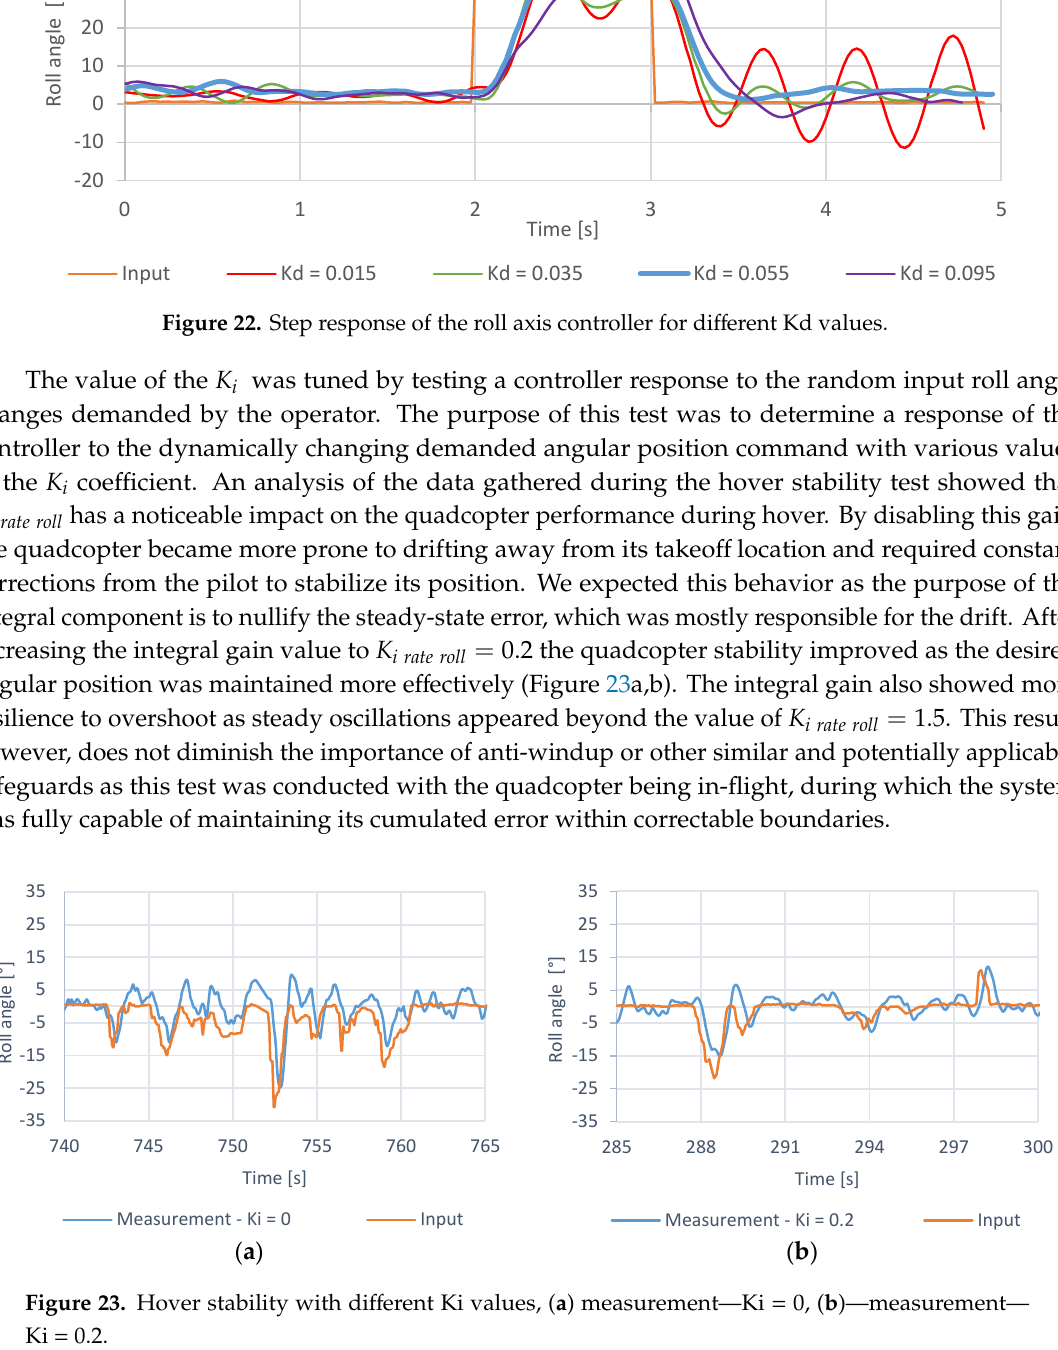
Table 3. Final control loop settings.